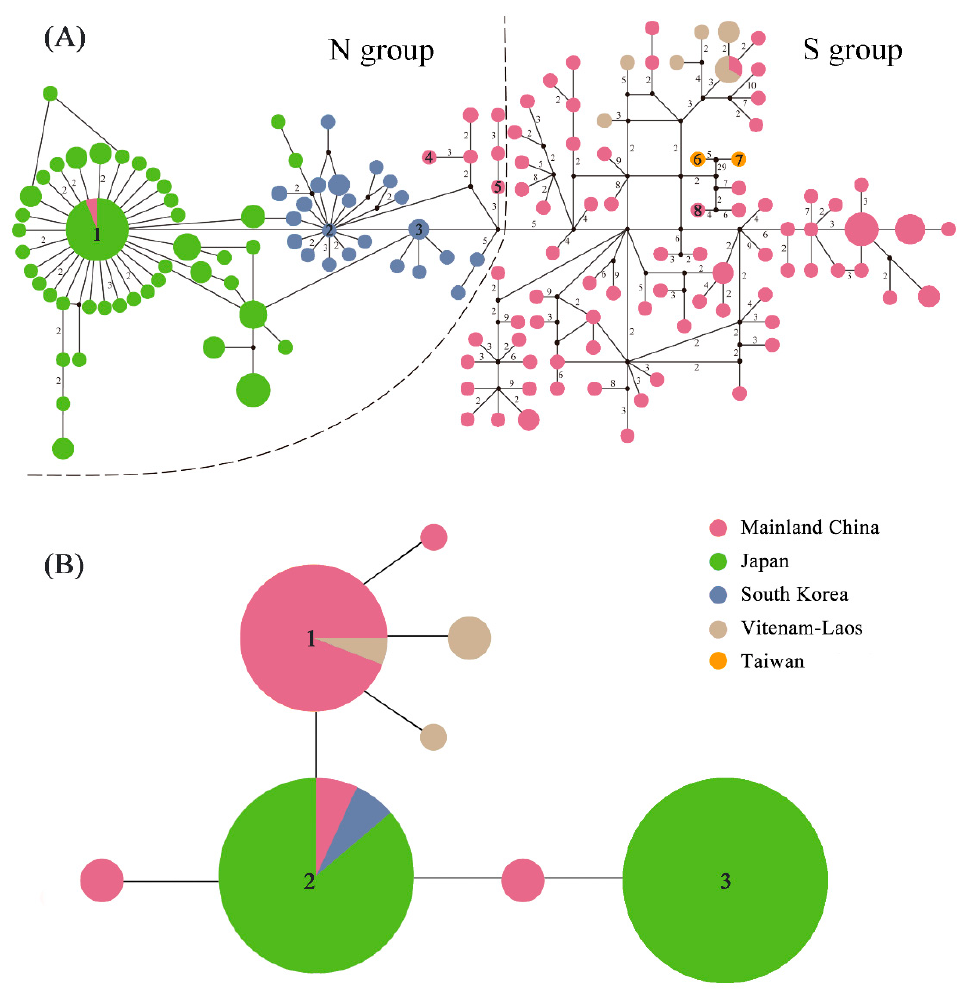
Figure 3. ( A ) Haplotype network estimated from the concatenated mitochondrial dataset and ( B ) nuclear gene sequences. Small black circles represent missing haplotypes. Distances between linked haplotypes corresponded to one mutation, except where otherwise specified. Circle sizes are proportional to numbers of haplotypes. Numbers in the circles represent haplotype numbers.